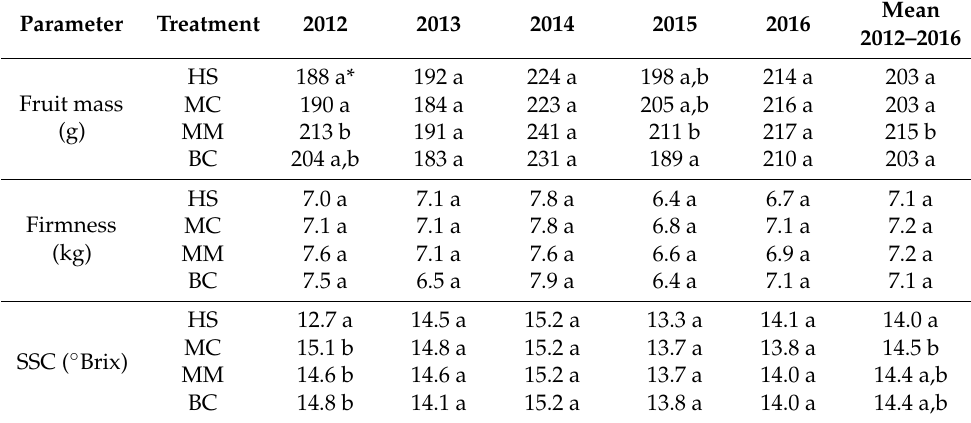
Table 2. Fruit quality parameters of apple trees cv. Gold Chief depending on the soil management system measured directly after harvest during 2012–2016.